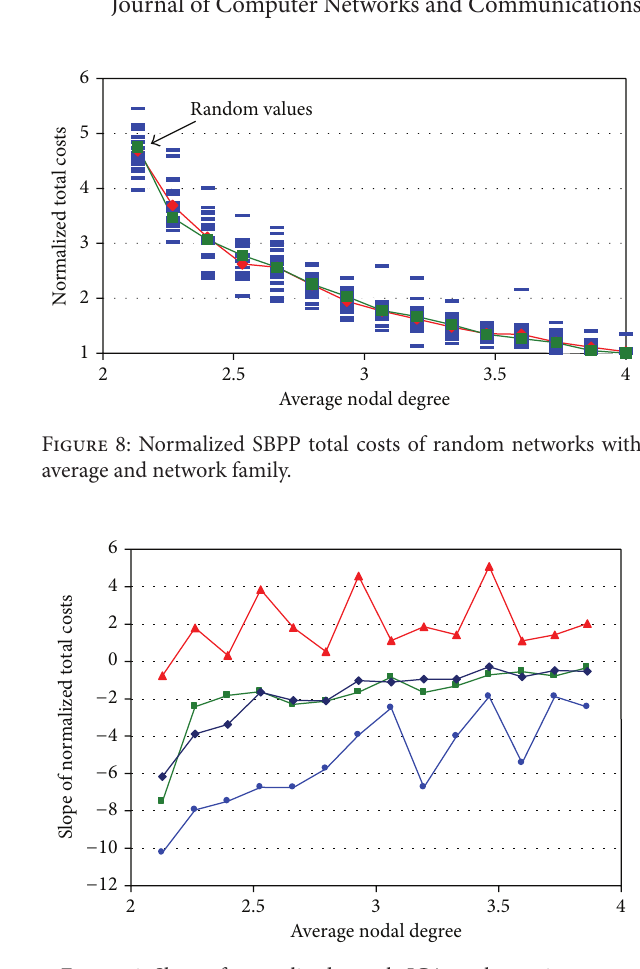
Figure 9: Slope of normalized p -cycle JCA total capacity